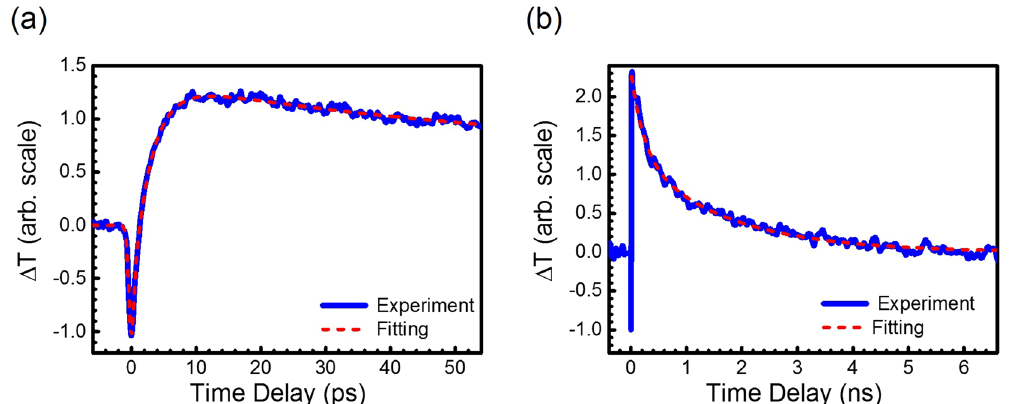
Figure 4. The transient transmission changes of the probe pulses through the Mn-doped GaN with concentrations of 1.2 × 10 20 cm − 3 . The pump/probe wavelength (photon energy) is 820 nm (1.5 eV). They were monitored by the probe pulses in different experimental setups for ( a ) short and ( b ) long observation windows.